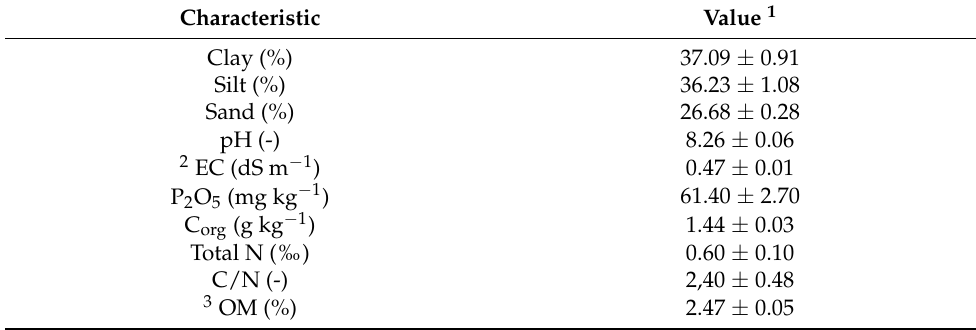
Table 1. Main physicochemical characteristics of soil